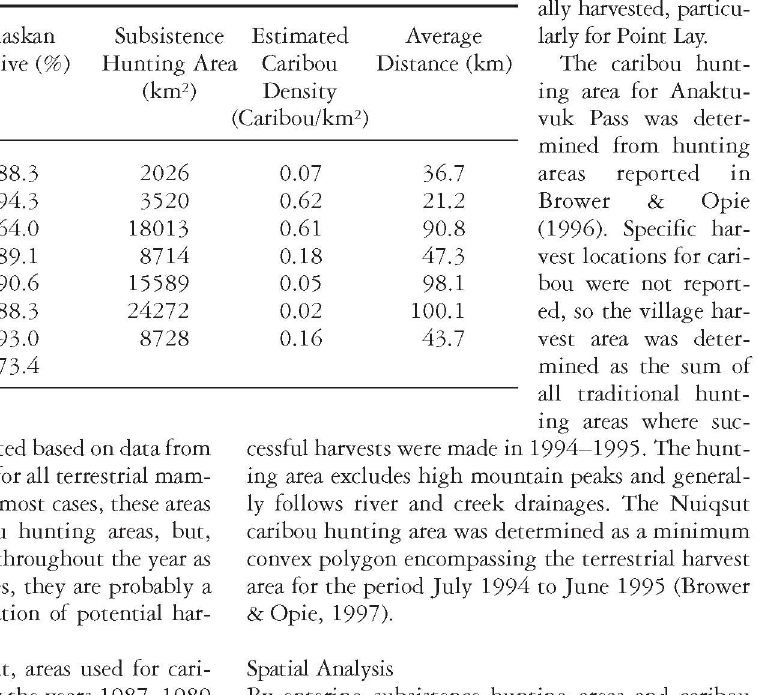
Table 1. Human population data (2000 census) and the approximate size of subsistence hunt ing areas, as well as the estimated annual caribou density and average distance of Teshekpuk Herd caribou within the subsistence hunting areas for the seven villages that regularly harvest caribou from the Teshekpuk Herd. Density and distance were calculated based on 27 satellite-collared caribou